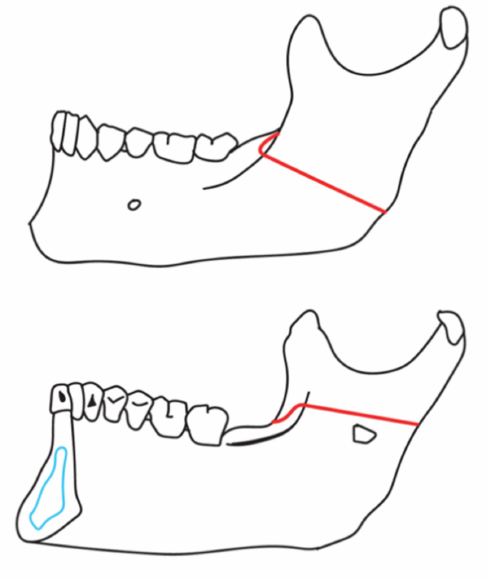
Figure 1. Schematic view of sagittal mandibular osteotomy modo